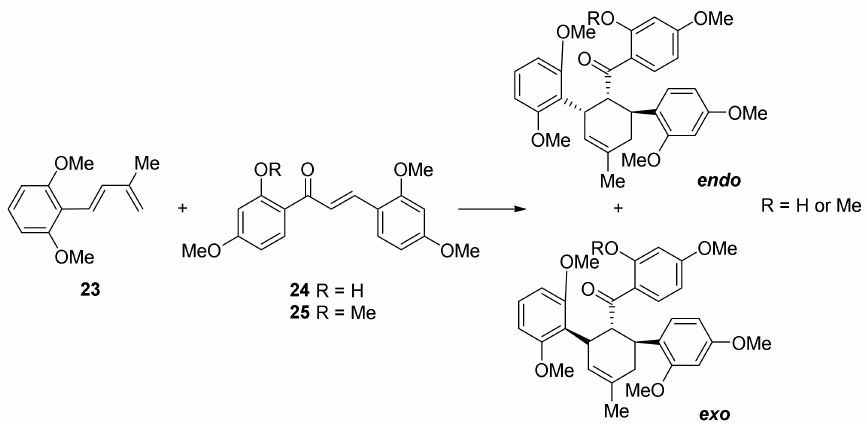
Figure 6. Model Diels–Alder reaction between 2 (cid:48) OH- ( 24 ) or 2 (cid:48) -OMe-chalcones ( 25 ) and diene ( 23 ) and corresponding endo and exo